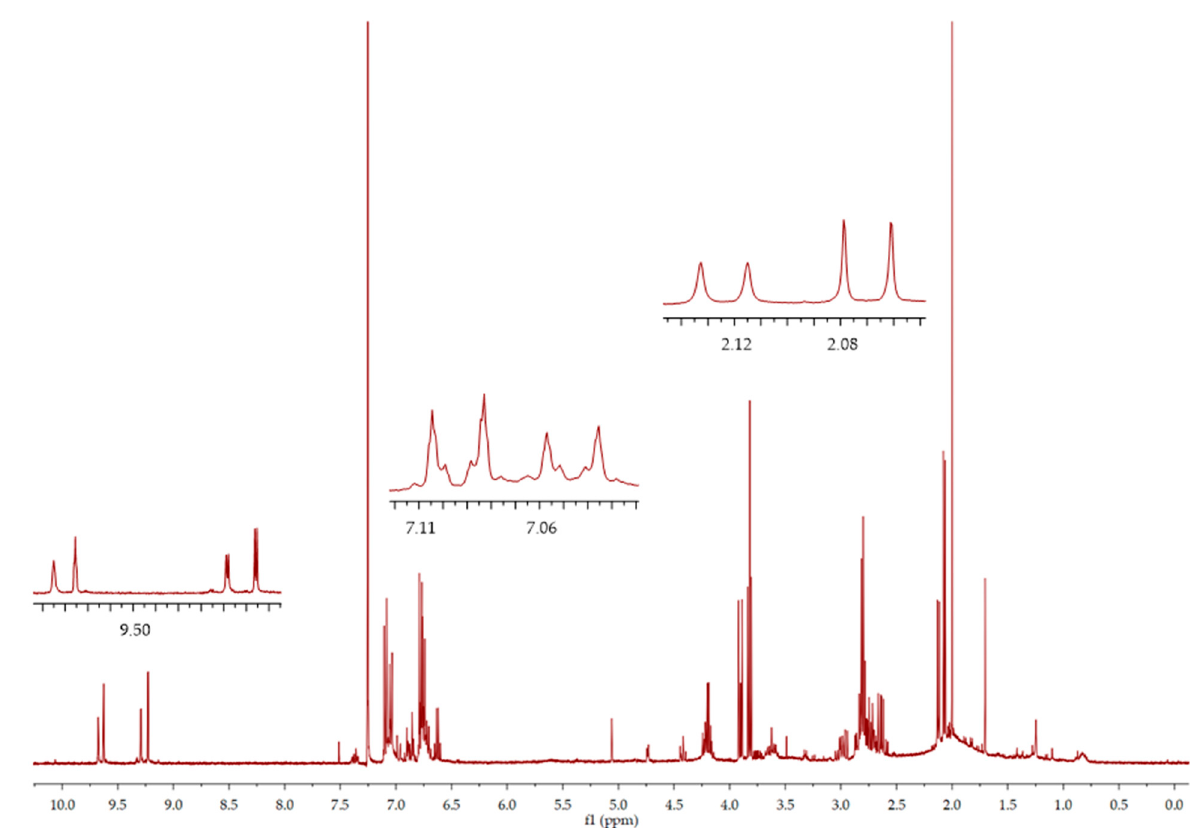
Figure 9. 1 H NMR spectra of oleocanthal 9 . Figure 9. 1 HNMR spectra of oleocanthal 9 . Figure 9. 1 HNMR spectra of oleocanthal 9 .